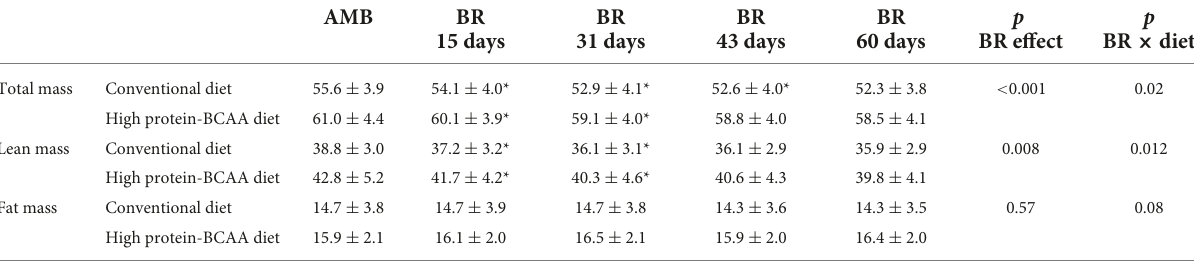
TABLE 2 Body composition in ambulatory condition and during 60-days of bed